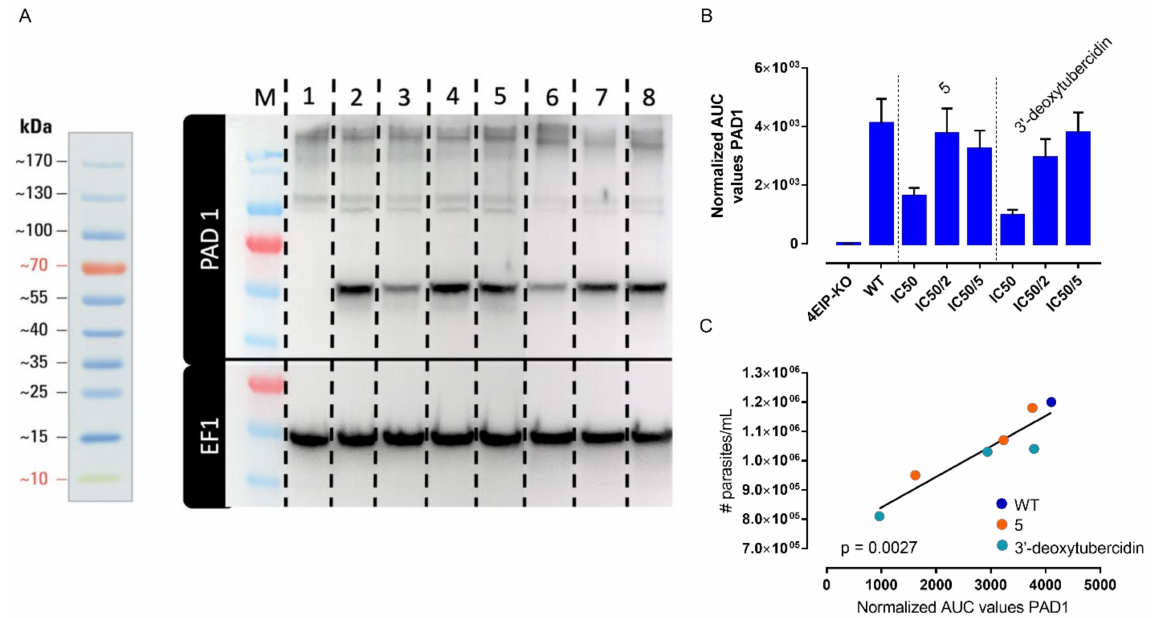
Figure 7. Western blot analysis for PAD1 expression. ( A ) PAD1 and EF1 protein expression (1: 4EIP-knockout, 2: untreated controls, 3–5: 5 -treated with IC 50 , IC 50 /2 and IC 50 /5 and 6–8: 3 (cid:48) -deoxytubercidin-treated with the IC 50 , IC 50 /2 and IC 50 /5). ( B ) EF1-normalized area under the curve (AUC) values for PAD1. ( C ) Correlation between the normalized AUC values for PAD1 and culture density at time of collection.